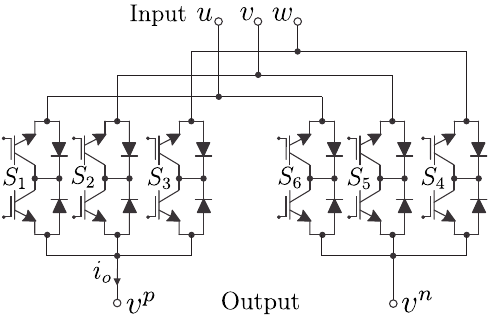
Figure 16. A single-phase matrix